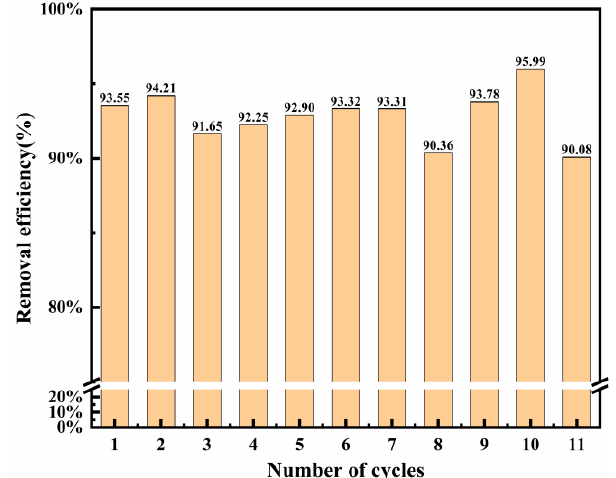
Figure 9. Reusability of LDO (calcinated at 480 °C) on Cl − adsorption (Cl − initial concentration: 2000 mg L − 1 ; adsorbent dosage: 2 g; adsorption temperature: 293 K; contact time: 13 h).